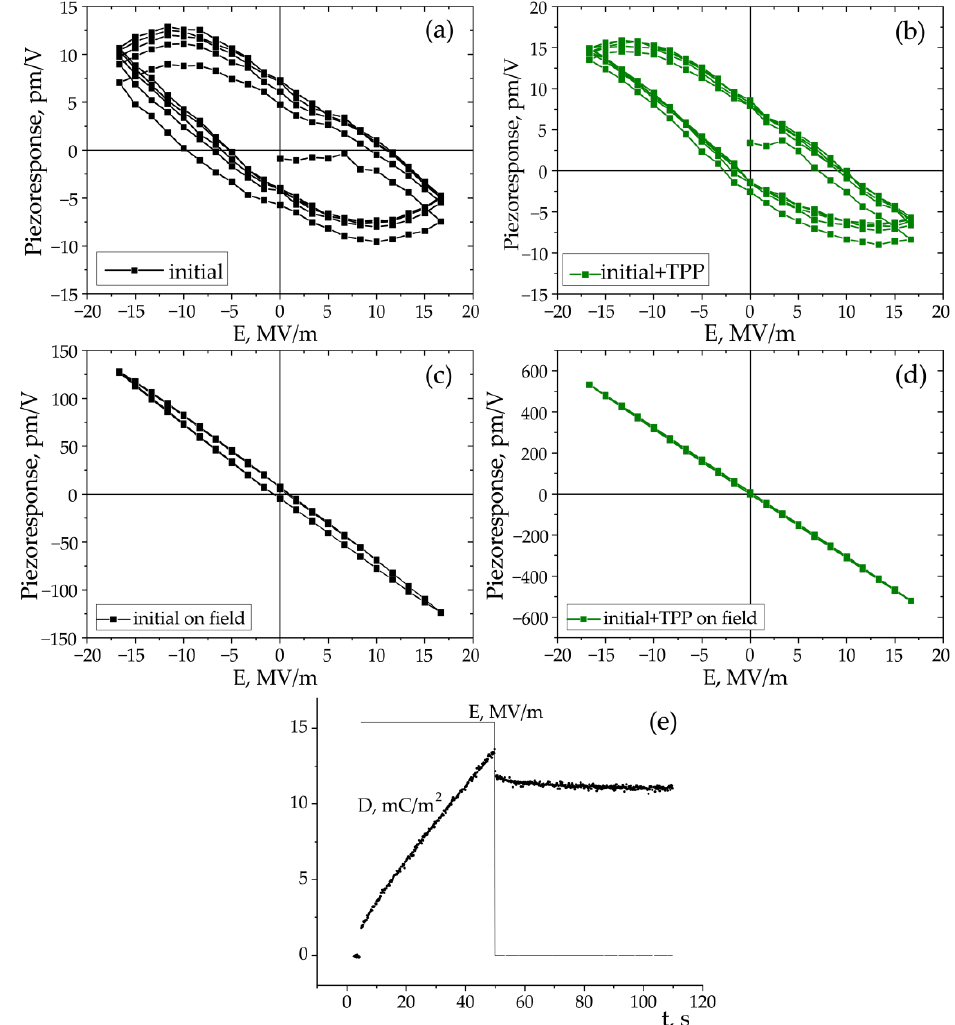
Figure 15. Local hysteresis loops obtained in “out -of- field” ( a , b ) and “in - field” ( c , d ) modes; ( e ) response of the initial film to a rectangular field pulse followed by the signal relaxation.